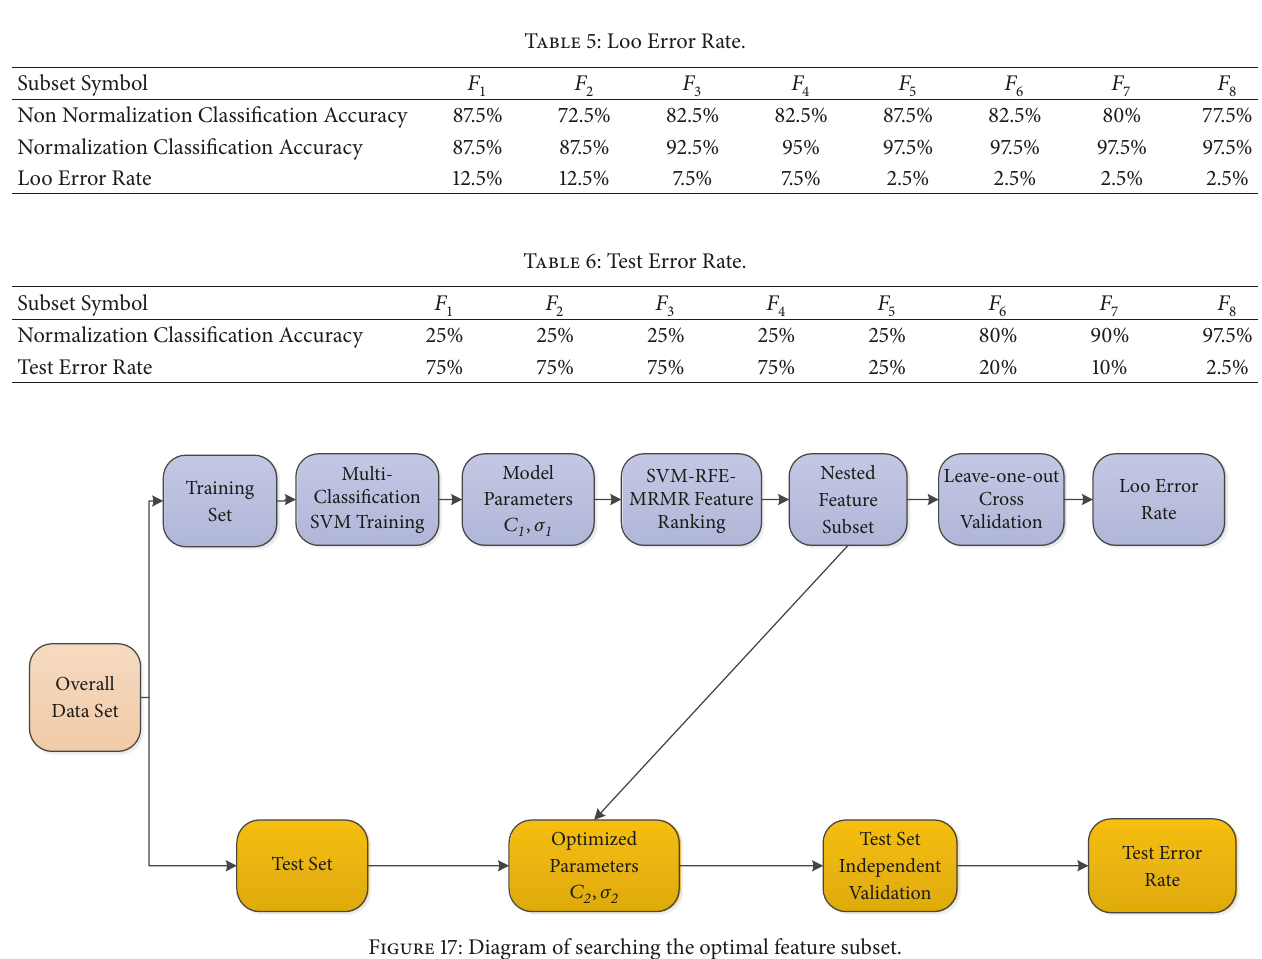
Figure 17: Diagram of searching the optimal feature